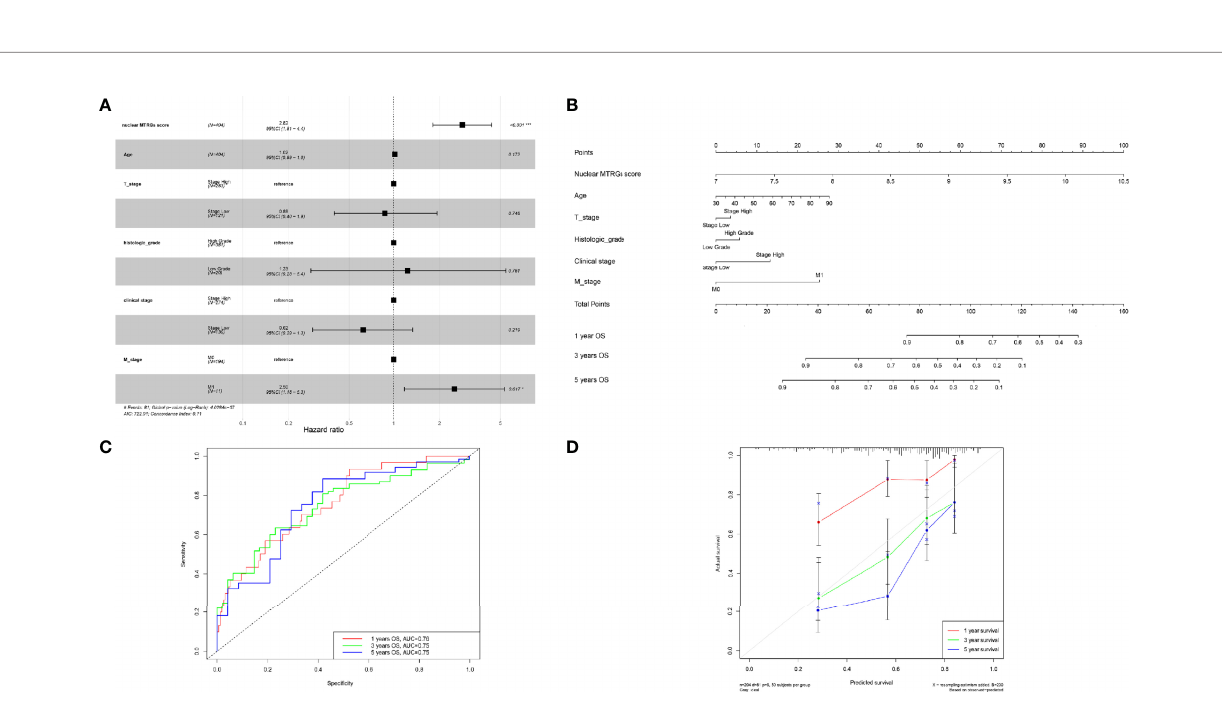
FIGURE 8 | The pro fi les of mutated genes between the high and low nuclear MTRGs score groups from the TCGA cohort. (A) The mutation pro fi le of the top 20 most frequently mutated genes in the high MTRGs score group. (B) The mutation pro fi le of the top 20 most frequently mutated genes in the low MTRGs score group.